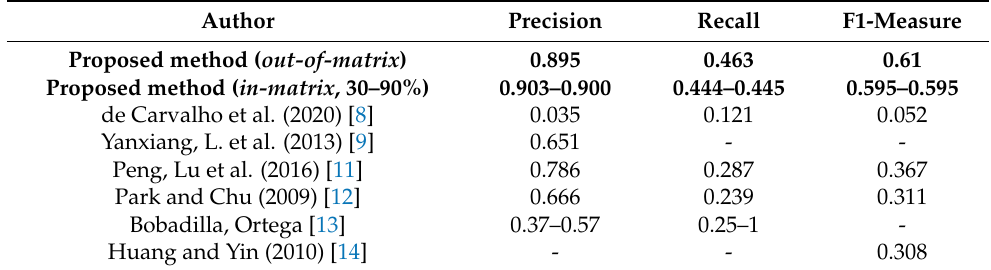
Table 3. Comparison to similar